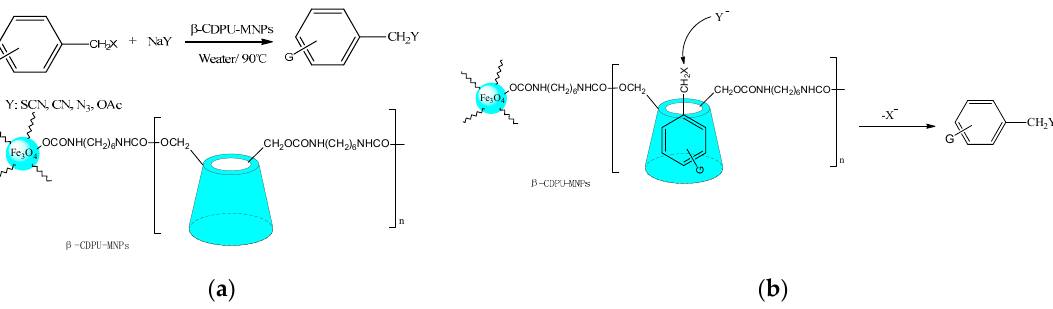
Scheme 16. ( a ) The substitution reaction of benzyl halides catalyzed by β -CDPU-MNPs; ( b )